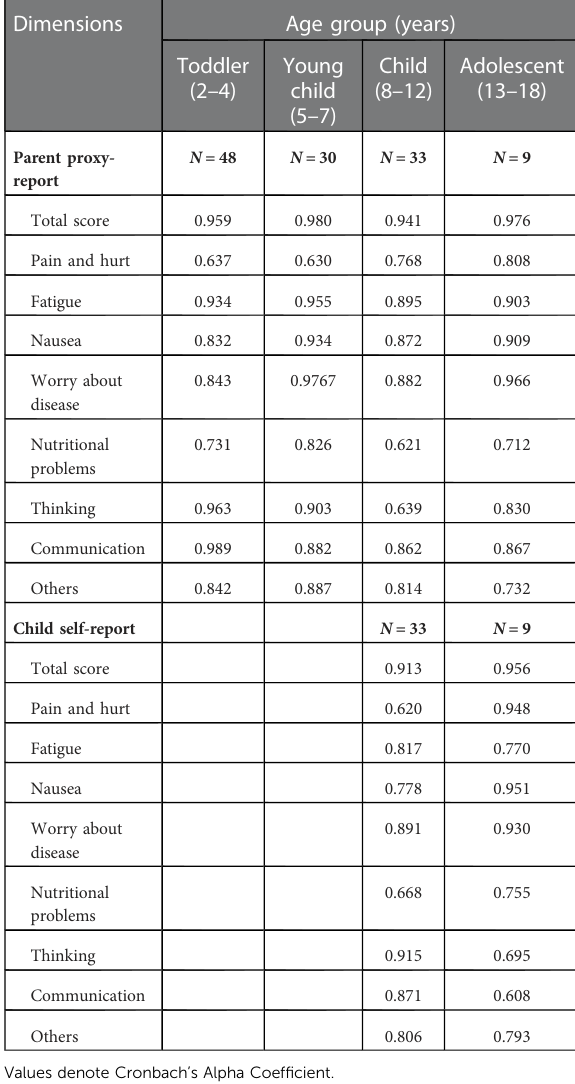
TABLE 4 Internal consistency reliability of the stem cell transplant